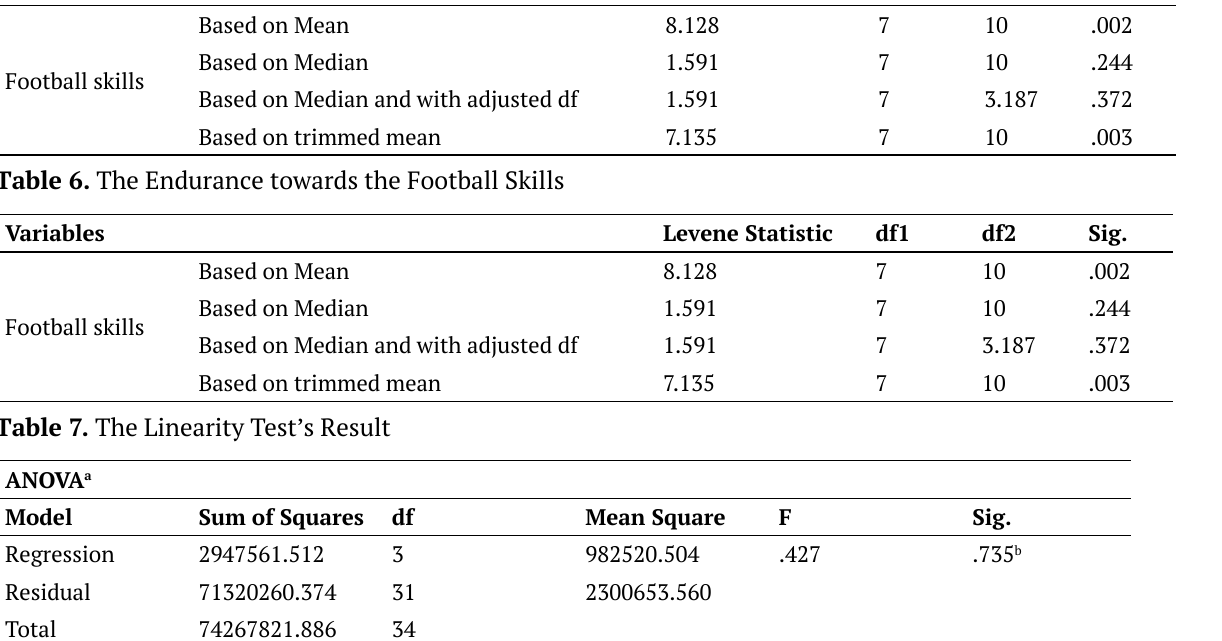
Table 5. The Agility towards the Football Skills Variables